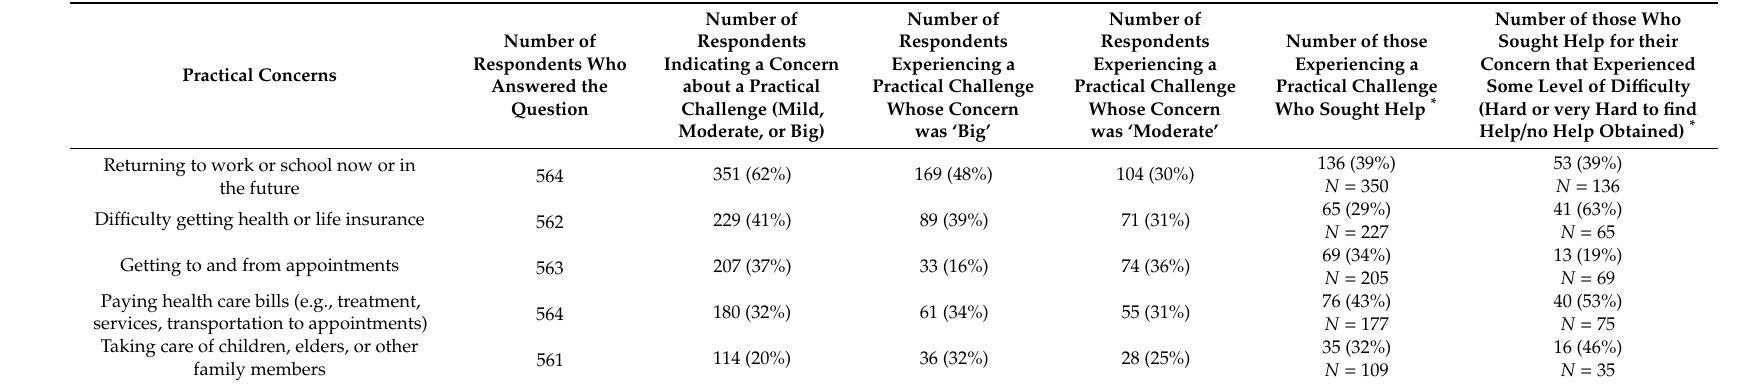
Table 4. Practical concerns prevalent and ease of accessing help in AYA